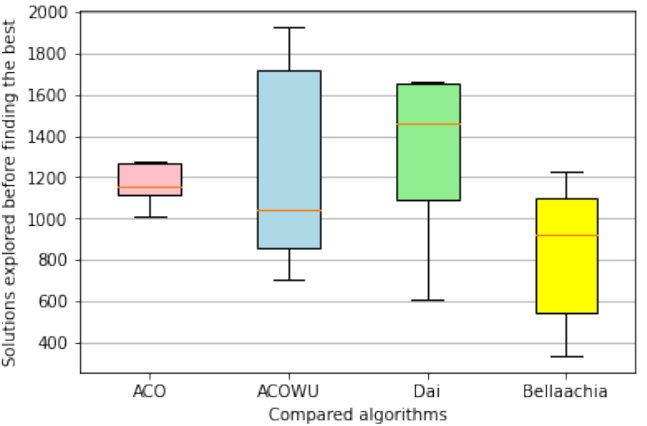
Figure 6. Results obtained in warehouse in terms of solutions explored.